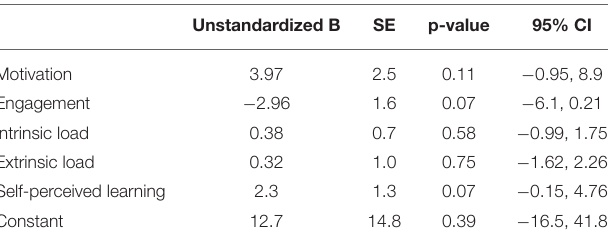
TABLE 2 | Influence of motivation, engagement, intrinsic load, extrinsic load, and self-perceived learning in the change of non-CLT face-to-face lecture scores (post–pre) in all participants ( n =